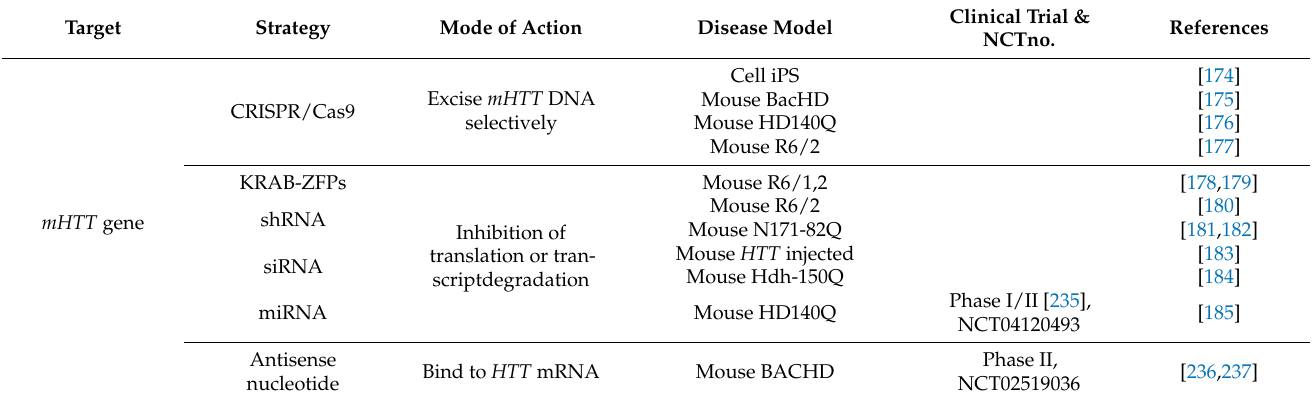
Table 2. Therapeutic targets for